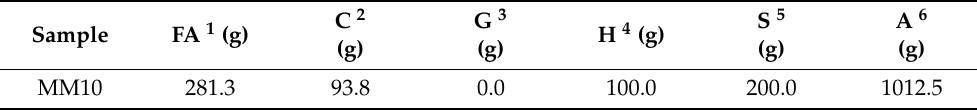
Table 6. Composition of the reference